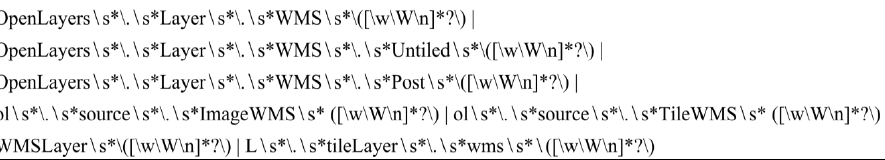
Table 2. Invocation functions and the formalization of the first rule.